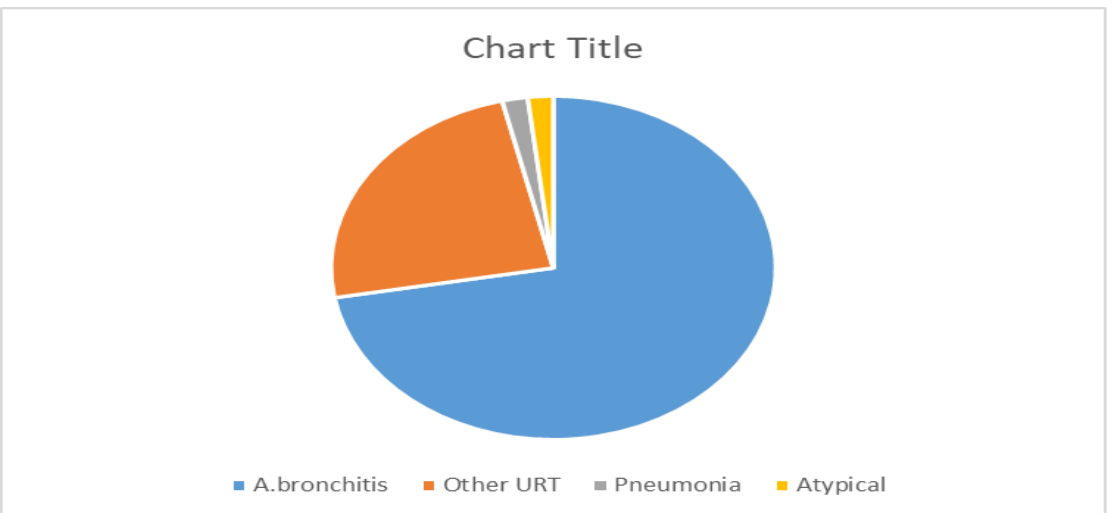
Figure 2. Distribution of HRV among clinical